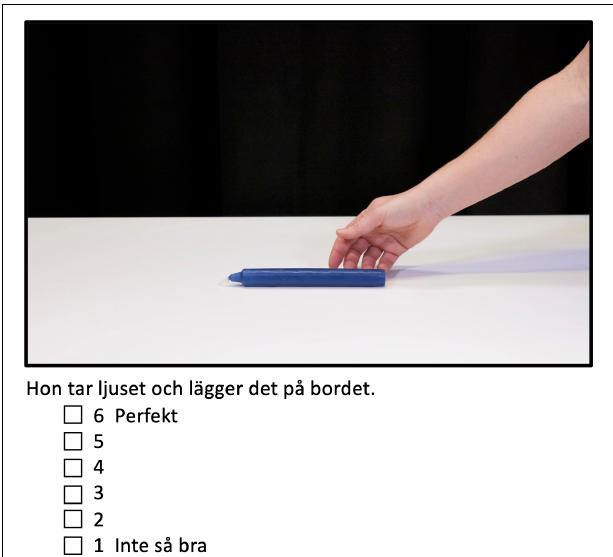
FIGURE 1 | Appropriateness ratings of how well the verb fits the depicted event. Participants rated the sentence, such as in the example above; Hon tar ljuset och lägger det på bordet “She takes candle.DET and lays it on table.DET” by ticking the box next to the numbers from 1 Inte så bra “Not so good” to 6 Perfekt “ Perfect” in an untimed questionnaire.